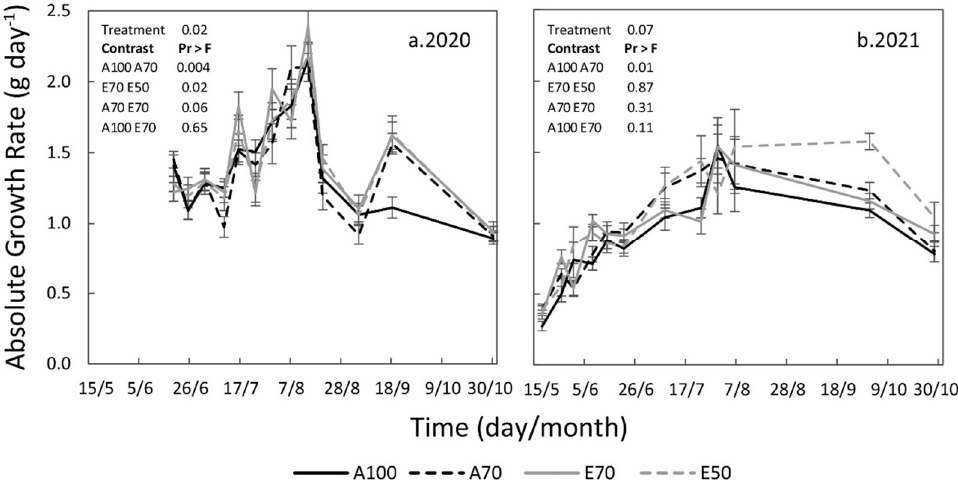
Figure 6. Seasonal patterns of fruit absolute growth rate throughout 2020 ( a ) and 2021 ( b ), for each treatment. Vertical bars represent standard error values. For each year, the effect of the treatment and linear contrast F values are shown and refer to the mean seasonal value of AGR; values below 0.05 are considered significant.